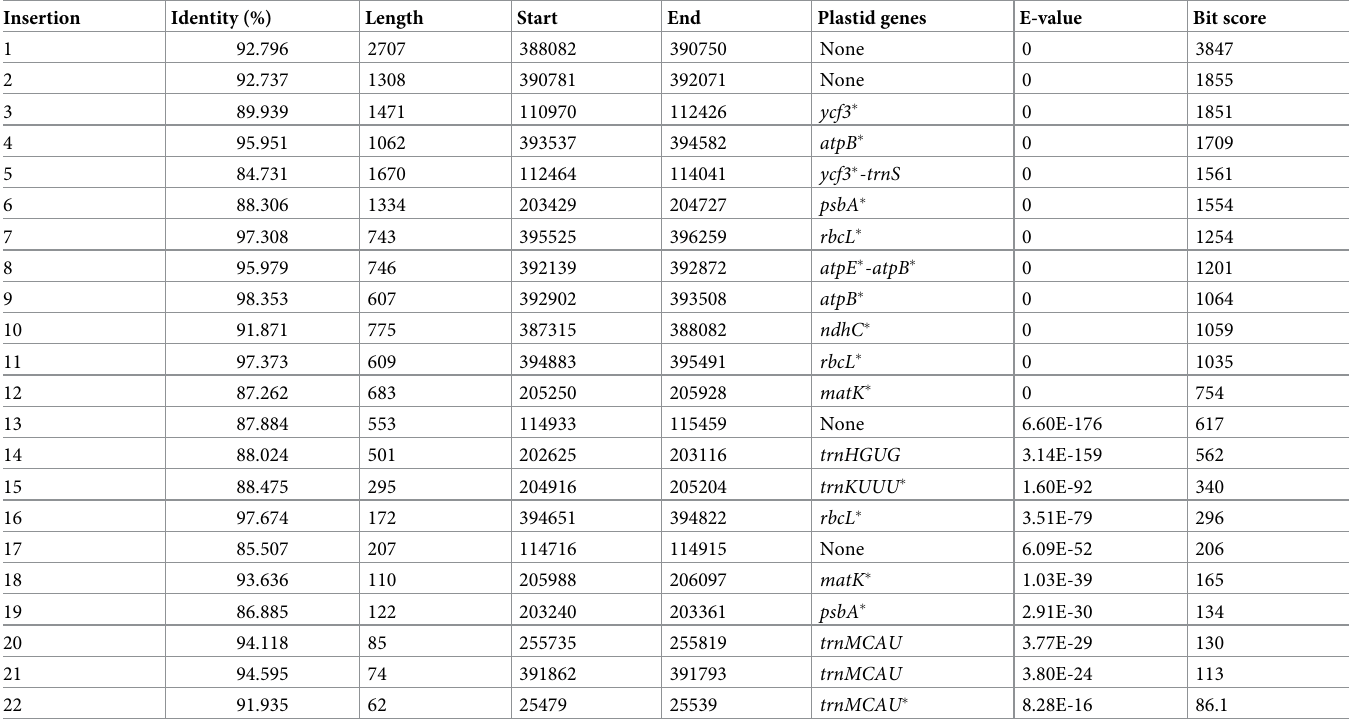
Table 3. Plastid insertions in the mitochondrial genome of Cycas debaoensis